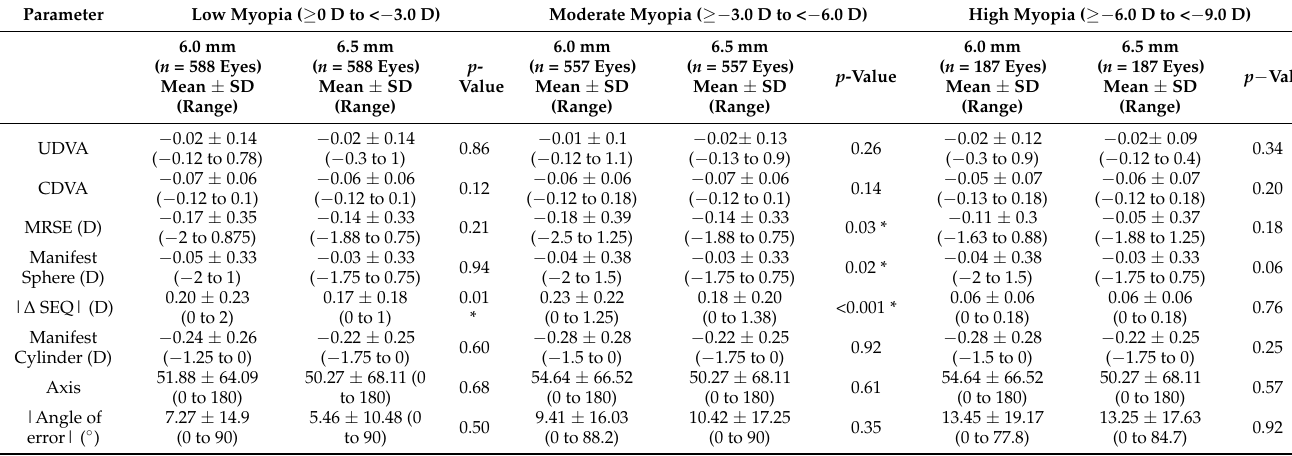
Table 3. Postoperative results stratified by severity of